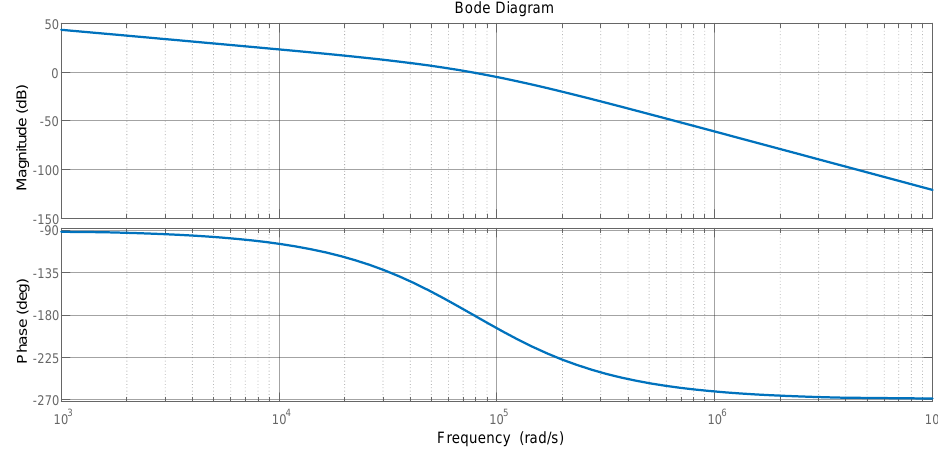
Figure 5. Frequency analysis of the damped LCL filter.